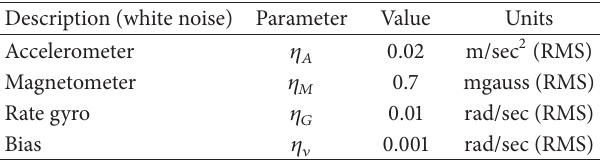
Figure 8: Euler’s angles estimated (NOL) and real data (CAU). Table 2: Sensors noise